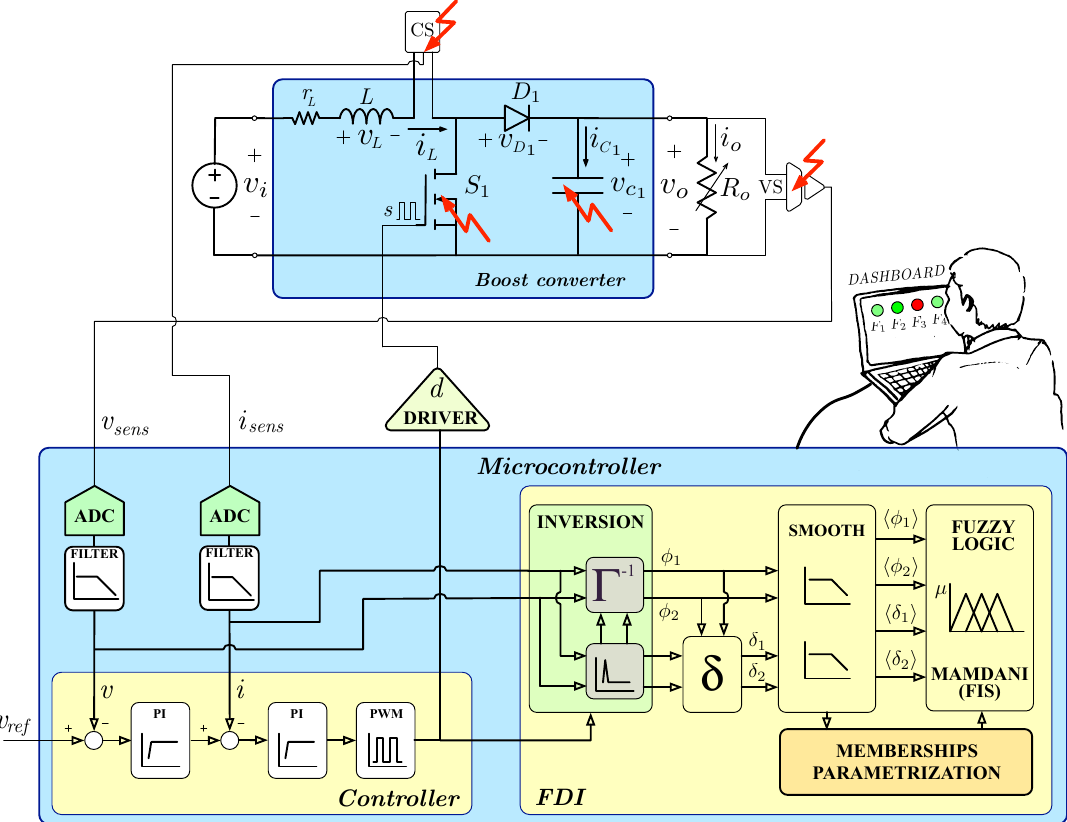
Figure 12. General overview of the implemented